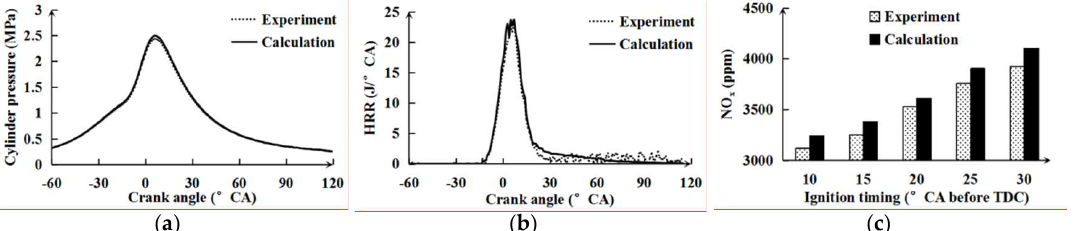
Figure 4. Comparison of calculated and measured ( a ) cylinder pressures, ( b ) heat release rates (HRRs), and ( c ) global NO x emissions. TDC, top dead centre.